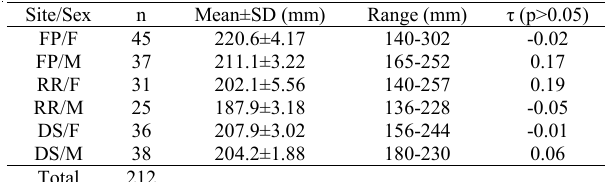
Table 1. Correlation analysis between standard length and energy density of female (F) and male (M) Loricariichthys platymetopon in the upper Paraná River floodplain (FP), Rosana Reservoir (RR) and Diamante Stream (DS). Number of specimens sampled (n), mean ± standard deviation (Mean± SD), range of standard length, values of the Kendall-tau ( τ ) correlation coefficient. For all correlations presented